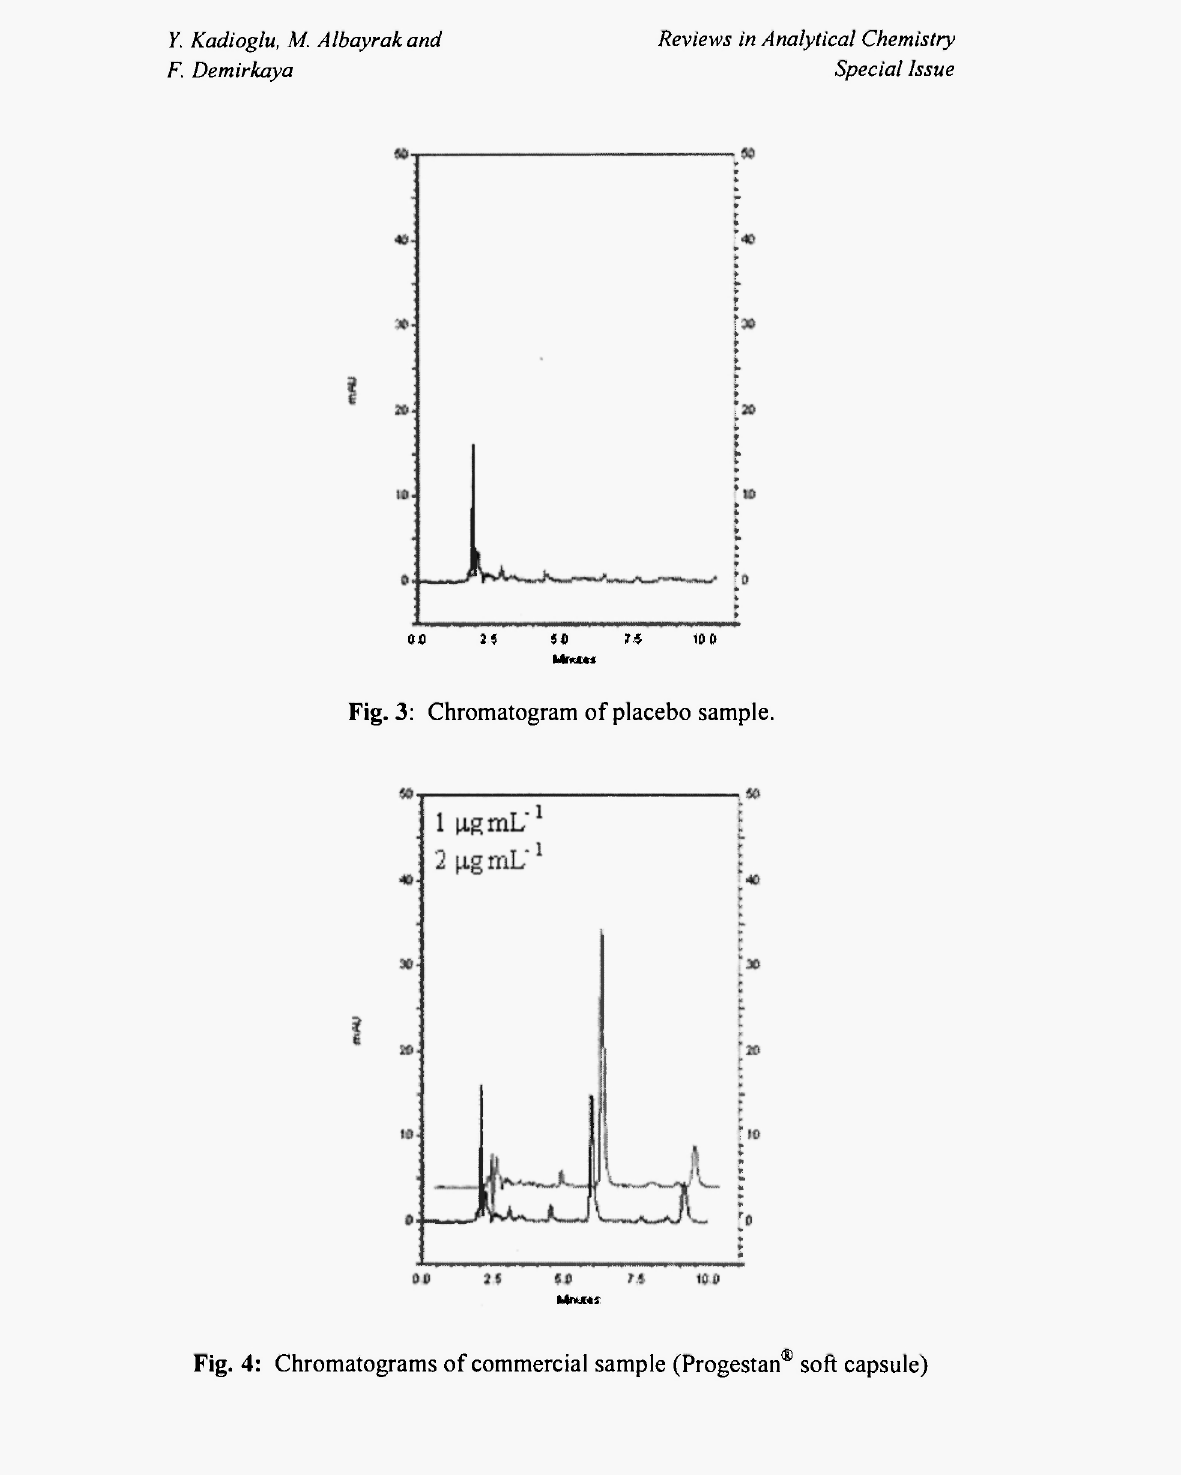
Fig. 4: Chromatograms of commercial sample (Progestan® soft